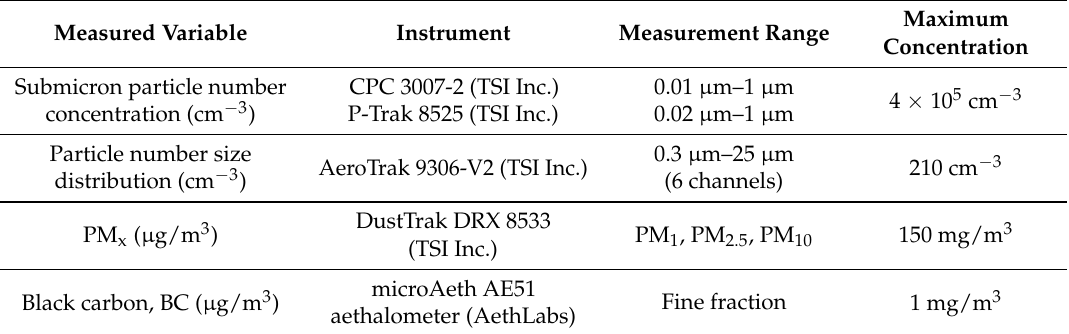
Table 1. List of aerosol instrumentation and measured variables involved in the mobile air pollution measurement campaign in